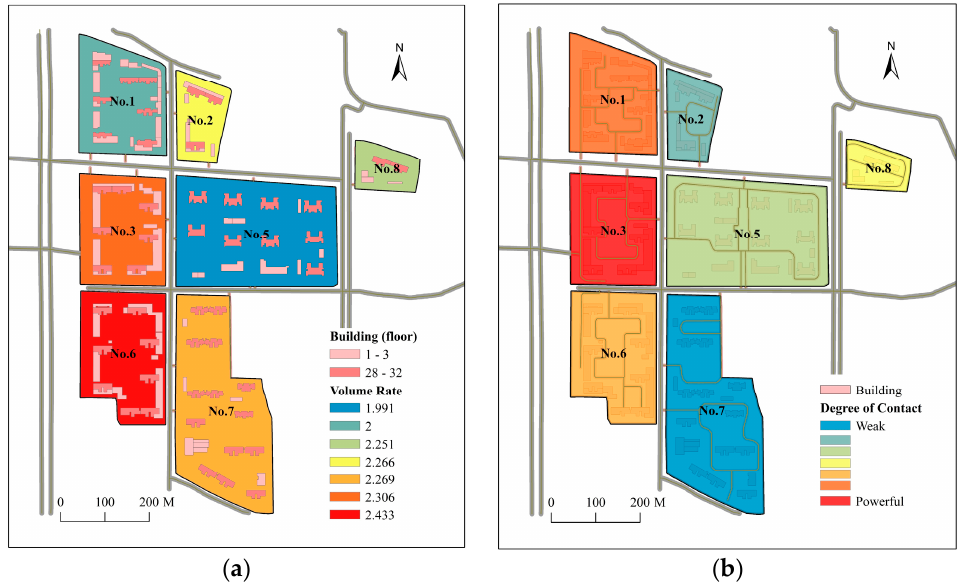
Figure 4. Calculation results of spatial indicator in the Jinghu Community: ( a ) plot ratio; ( b ) shape index.